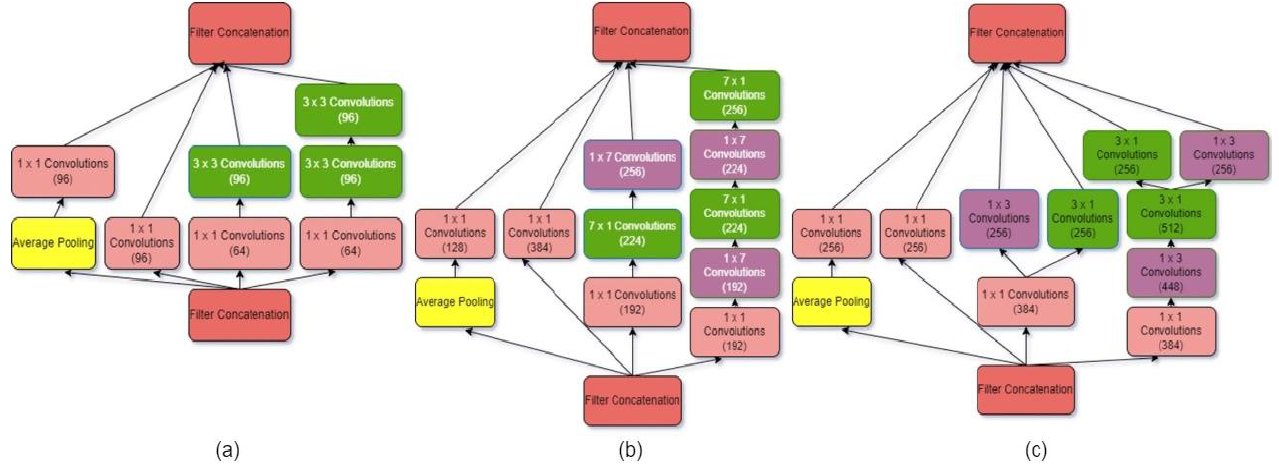
Figure 4. Details of Inception V4 architecture with ( a – c ) layers.